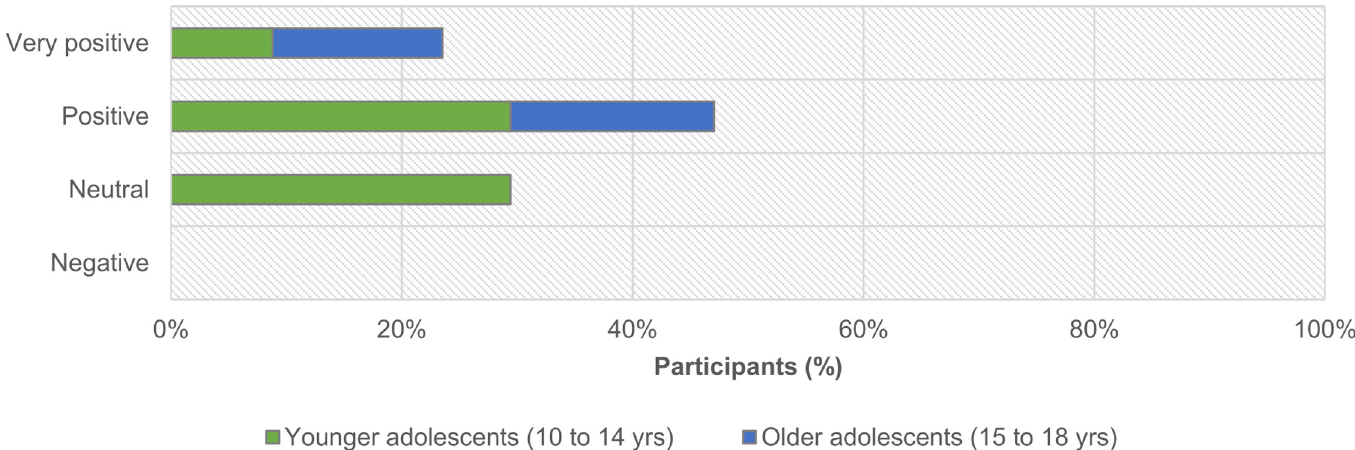
Fig 12. Distribution of participants (n = 34), according to age groups, by the degree of the evaluative judgements expressed in their responses to the final free, open- ended activity.